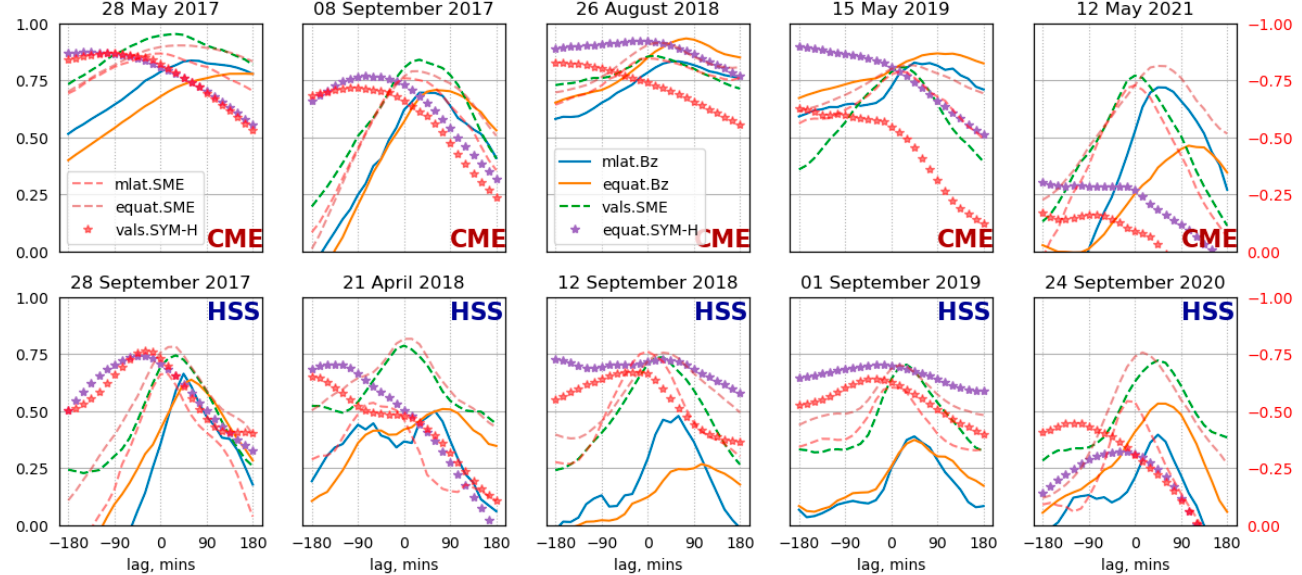
Figure 14. Cross-correlation between keogram derivatives and SW indices: Bz versus MLAT_max (blue), Bz versus equatorial boundary (orange), SYM-H versus equatorial boundary (purple stars), SYM-H versus max <ROTI> (red starts, reversed Y-axis at right), SME index versus max <ROTI> (green dashed), and SME versus MLAT_max and equatorial boundary (red and dark red dashed line; reversed Y-axis at right). Table 2. Cross-correlation maxima. Maximal ROTI Latitude of Maximal Latitude of Equatorward Values Versus ROTI Versus Boundary Versus